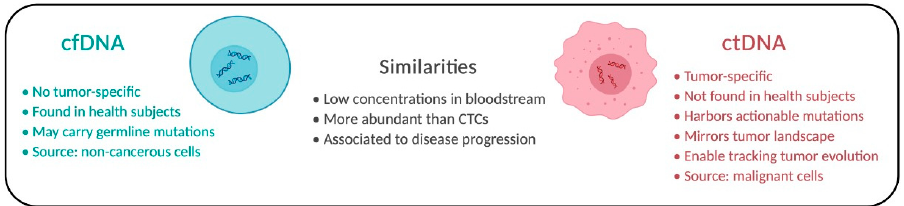
Figure 2. Comparison of cfDNA and ctDNA. Individual aspects and similarities of both molecules are described.